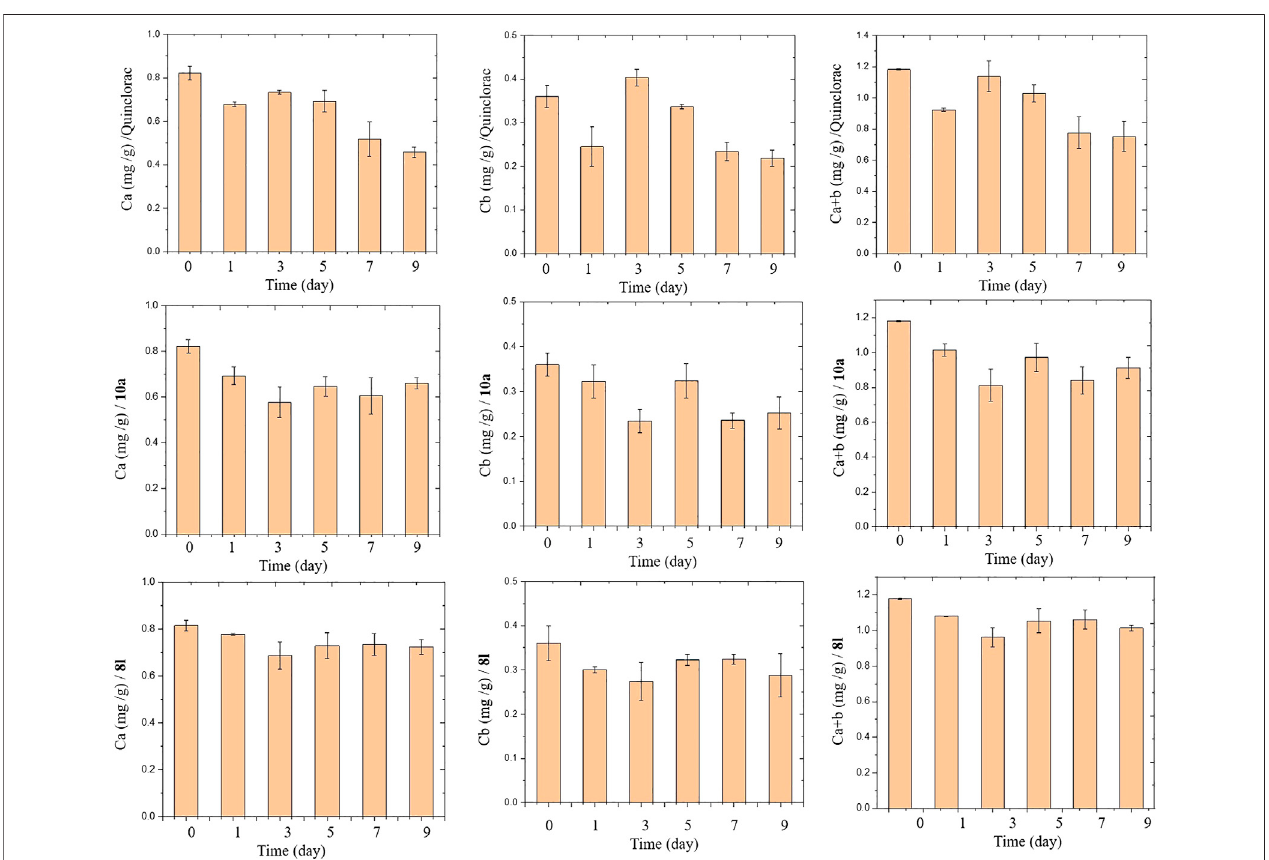
FIGURE 4 | The leaf chlorophyll a, b, and a + b contents at 2 ∼ 3 stages in barnyard grass seedling treated with quinclorac and compounds 8l and 10a during 0 – 9 days. Data are the mean + standard errors (SE).